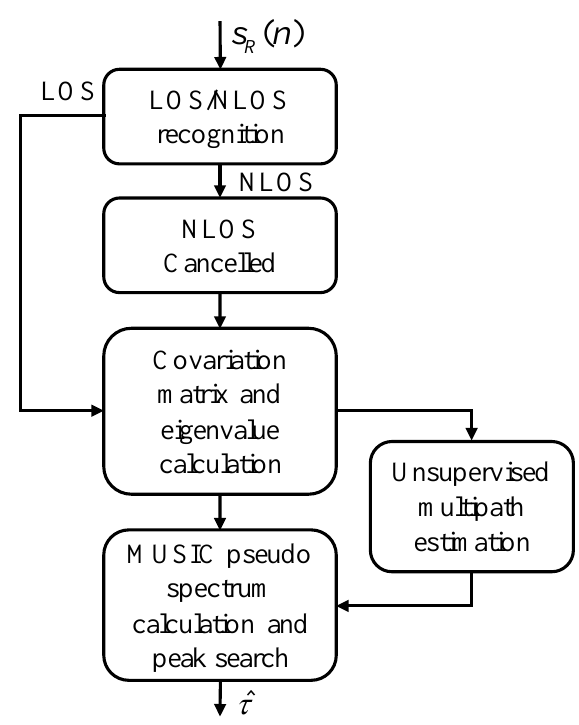
Figure 3. The structure diagram of the proposed NC-MUSIC algorithm.